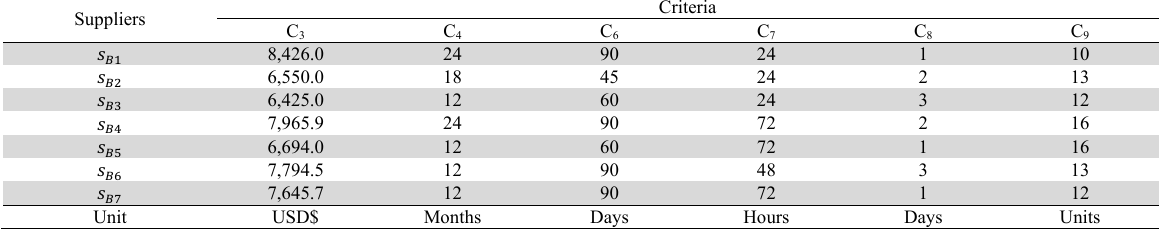
Consequences matrix for case